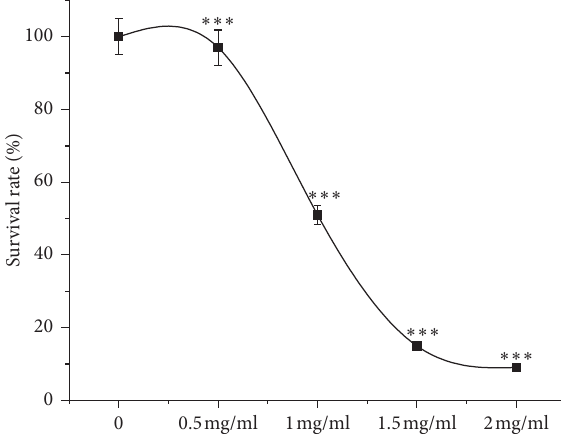
Figure 4: Effects of essential oils on survival rates in C. elegans . Results show at least three independent biological replicates. Error bars represent the standard error, and differences compared to the control (0mg/ml, 0.1% DMSO) were considered significant at ∗ p < 0 . 05, ∗∗ p < 0 . 01, and ∗∗∗ p < 0 . 001 by one-way ANOVA and the LSD post hoc test.